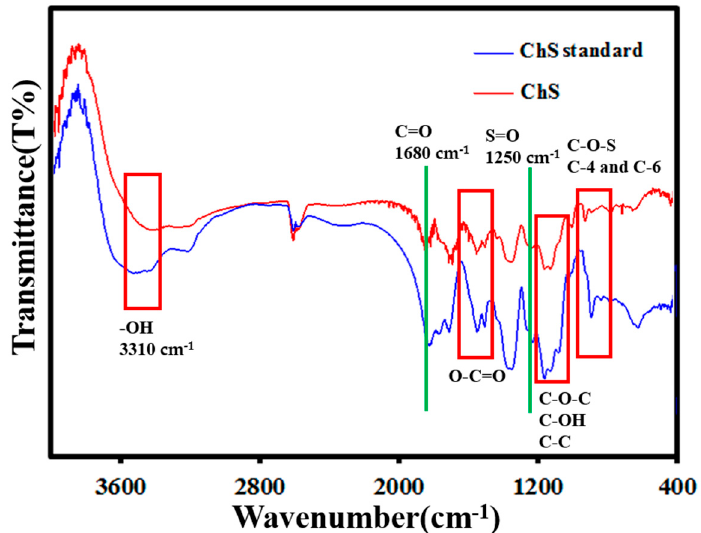
Figure 6. FTIR spectra of ChS standard (blue line) and purified jumbo squid ChS (red line) through 50% ethanol precipitation.